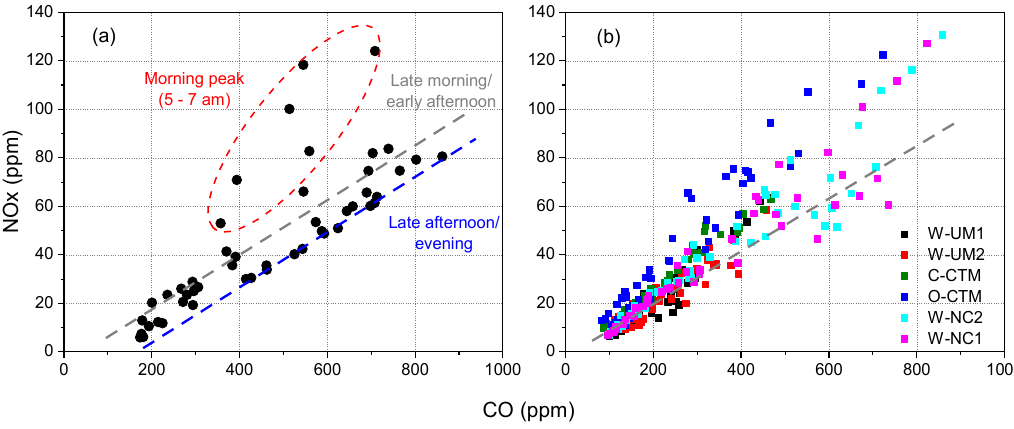
Figure 15. Relationship between NOx and CO at Westmead, category #3 and #4 days only, for ( a ) observed, and ( b ) simulated values. The grey and blue dashed lines in ( a ) are only to guide the eye, not regression fits; the grey line has been transferred to ( b ) for comparison purposes only.